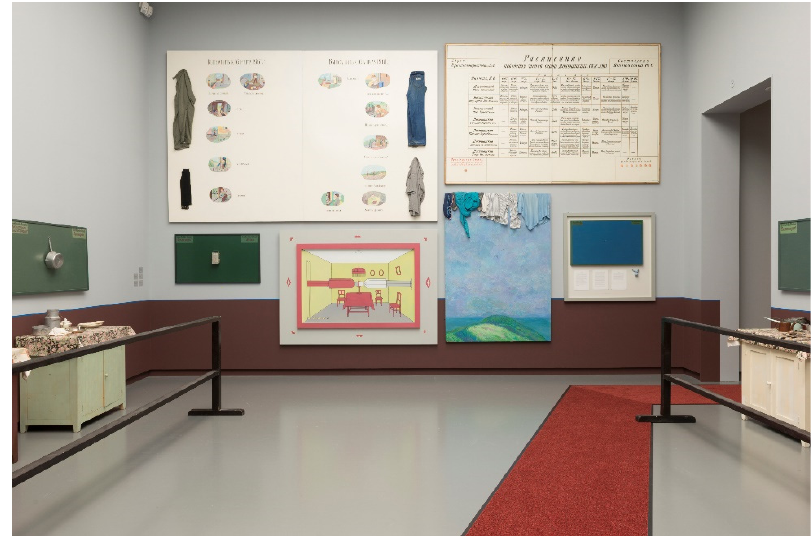
Figure 29. View of one of the rooms with works by Ilya Kabakov in the exhibition ‘Lissitzky–Kabakov: Utopia and Reality’, Van Abbemuseum, 2012. Photo: Peter Cox.